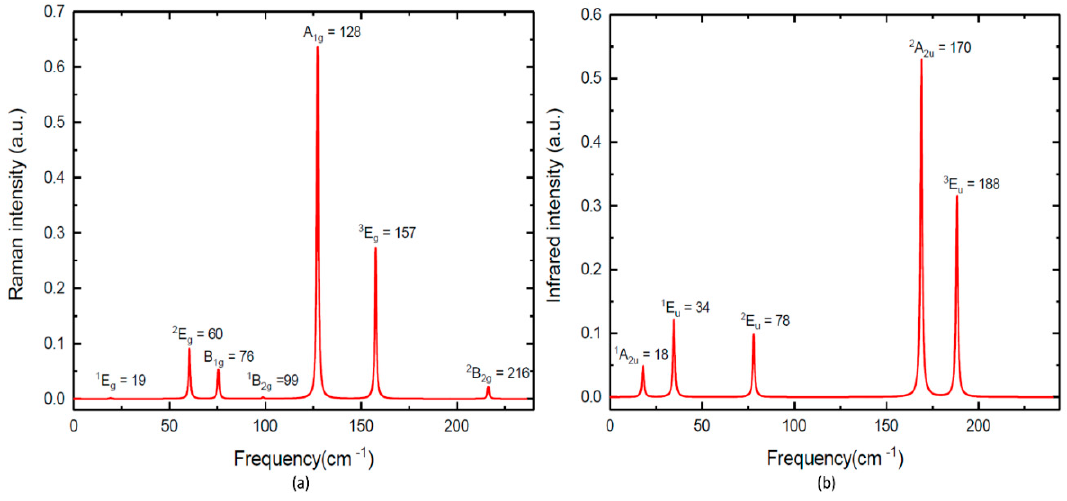
Figure 3. ( a ) Calculated Raman spectra of TlGaTe 2 ; ( b ) calculated infrared spectra of TlGaTe 2 . Table 2. Calculated phonon frequencies ω cal (in this work and previous work [31]) and their experimental values ω exp